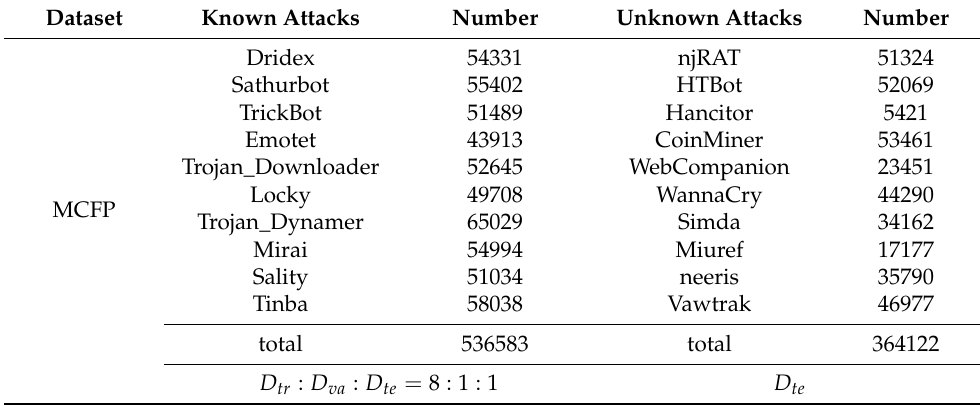
Table 1. The details of known and unknown attacks used in